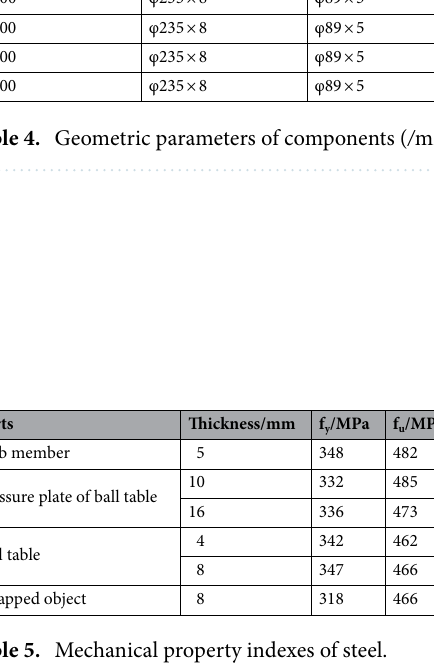
Table 5. Mechanical property indexes of